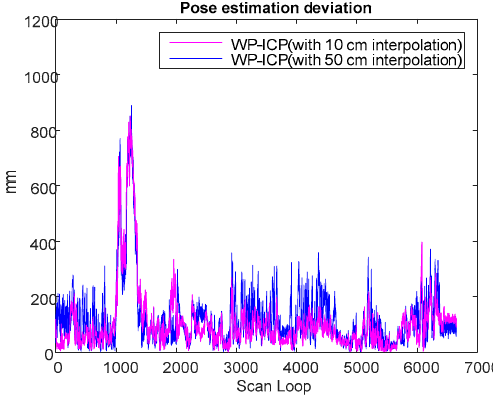
Figure 18. Pose estimation deviation of different interpolations.